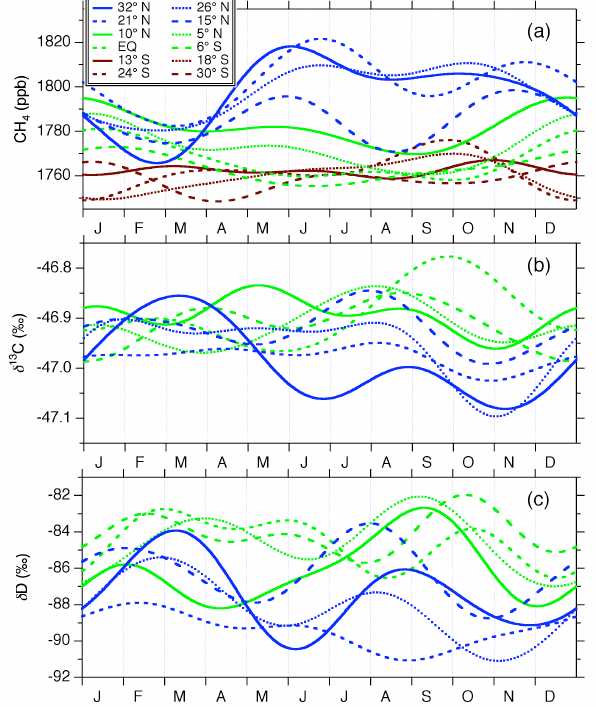
Fig. 3. Seasonal variations of (a) the CH 4 mixing ratio, (b) δ 13 C Figure 3. Seasonal variations of (a) the CH 4 mixing ratio, (b) δ 13 C and (c) δ D in the NH-UT 1001 and (c) δ D in the NH UT over the Western Pacific. Each line rep- over the western Pacific. Each line represents the average seasonal cycle added by the annual 1002 resents the average seasonal cycle added by the annual average in 2007. Clear seasonal cycles of δ 13 C and δ D are not observable in average in 2007. Clear seasonal cycles of δ 13 C and δ D are not observable in the SH and are 1003 the SH and are not shown. not shown. 1004